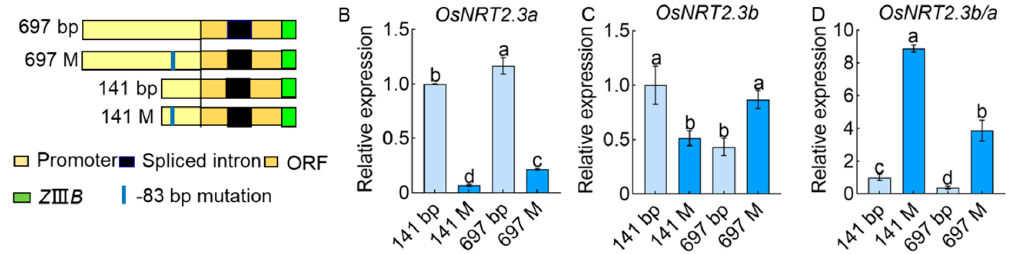
Figure 7. Effects of TATA-box mutation at different length promoters influence the transcription of OsNRT2.3 in rice. ( A ) Schematic representation of the diagram of different lengths of OsNRT2.3 promoter fragments; TATA-box mutation fragments promote the 437 bp ORF of OsNRT2.3 and the ZIIIB reporter gene; 141 and 697 bp are the different lengths of the original OsNRT2.3 promoter; 141M and 697M are the different lengths of the OsNRT2.3 promoter containing the TATA-box mutation site. Yellow frames, promoters of OsNRT2.3 . Black frames, spliced intron. Brown frames, ORF of OsNRT2.3a and OsNRT2.3b . Green frames, ZIIIB reporter gene. Blue line, TATA-box mutation site, − 83 bp upstream of OsNRT2.3 ATG. Obtained transgenic lines planted in a solution containing 1.25 mM NH 4 NO 3 of IRRI. The expression of OsNRT2.3a ( B ) and OsNRT2.3b ( C ) in the transgenic lines. ( D ) The expression ratio of OsNRT2.3b to OsNRT2.3a in the transgenic lines. Error bars: SE (n = 3). The different letters indicate a significant difference between the transgenic lines. ( p < 0.05).